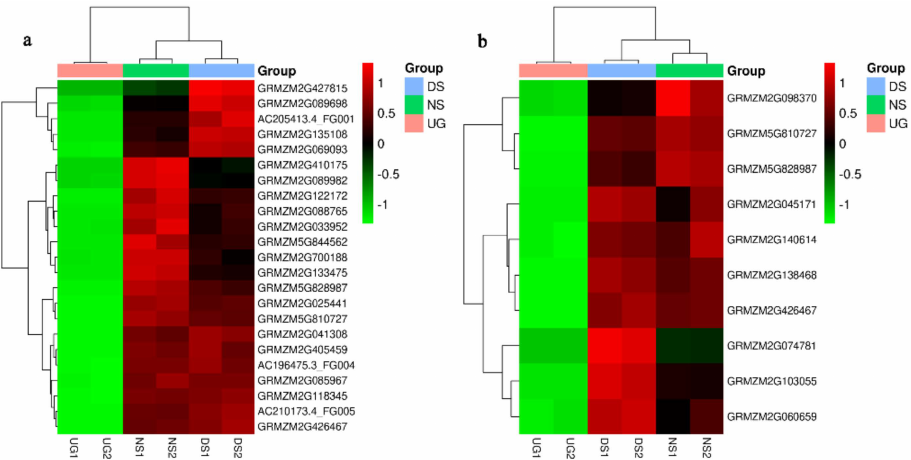
Figure 5. Detailed expression profile of DEGs related to the phenylpropanoid biosynthesis pathway ( a ) and the starch and sucrose metabolism pathway ( b ) based on KEGG analysis in maize embryos. Heat maps illustrate the relative expression level of these